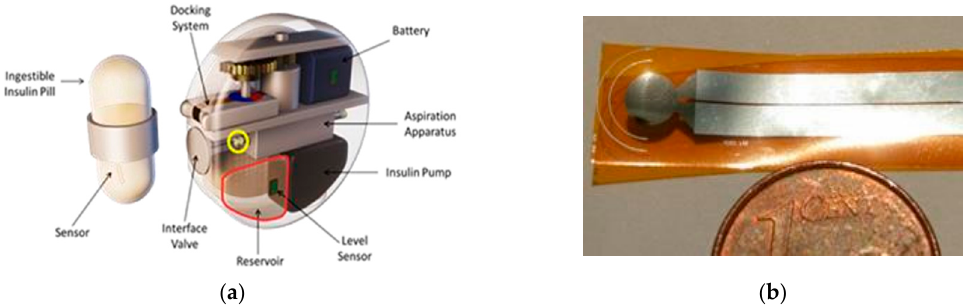
Figure 2. ( a ) Preliminary prototype of the implantable artificial pancreas; ( b ) image of the fabricated piezoelectric pressure sensor on kapton substrate.